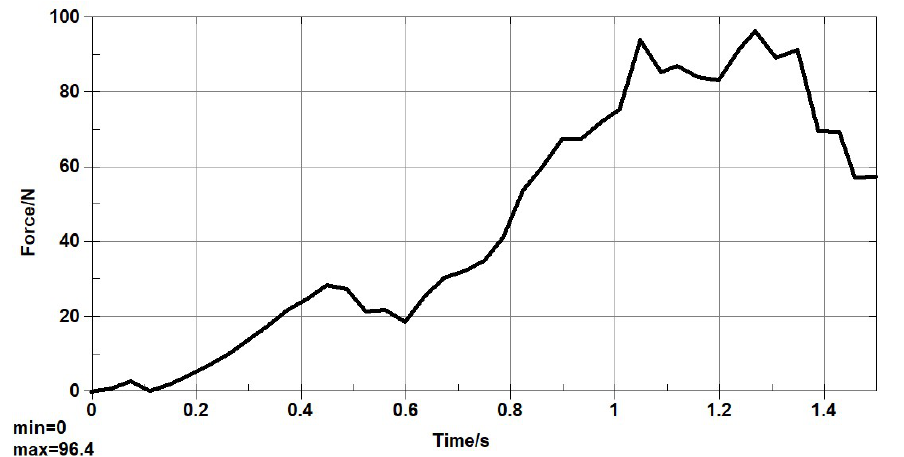
Figure 11. Simulation results graph. Table 1. Physical characteristics of citrus fruit.